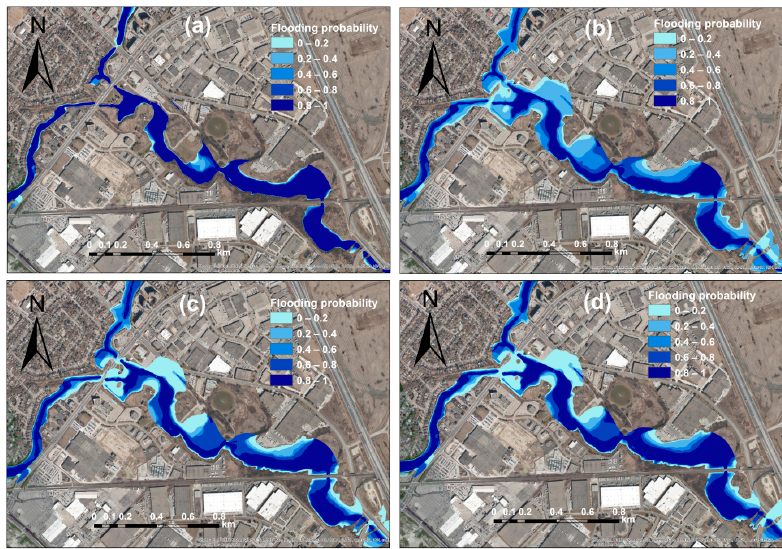
Figure 8. Probabilistic floodplain maps under future climate change from different data source for one upstream location: ( a ) current period; ( b ) 2040–2069 under RCP8.5 from CCDP; ( c ) 2030–2070 under RCP.8.5 from stationary IDF; and ( d ) 2030–2070 under RCP8.5 from non-stationary IDF. Table 6. Comparison of mean water level of selected upstream and downstream cross section for different scenarios: ( a ) current period; ( b ) 2040–2069 under RCP8.5 from CCDP; ( c ) 2030–2070 un-